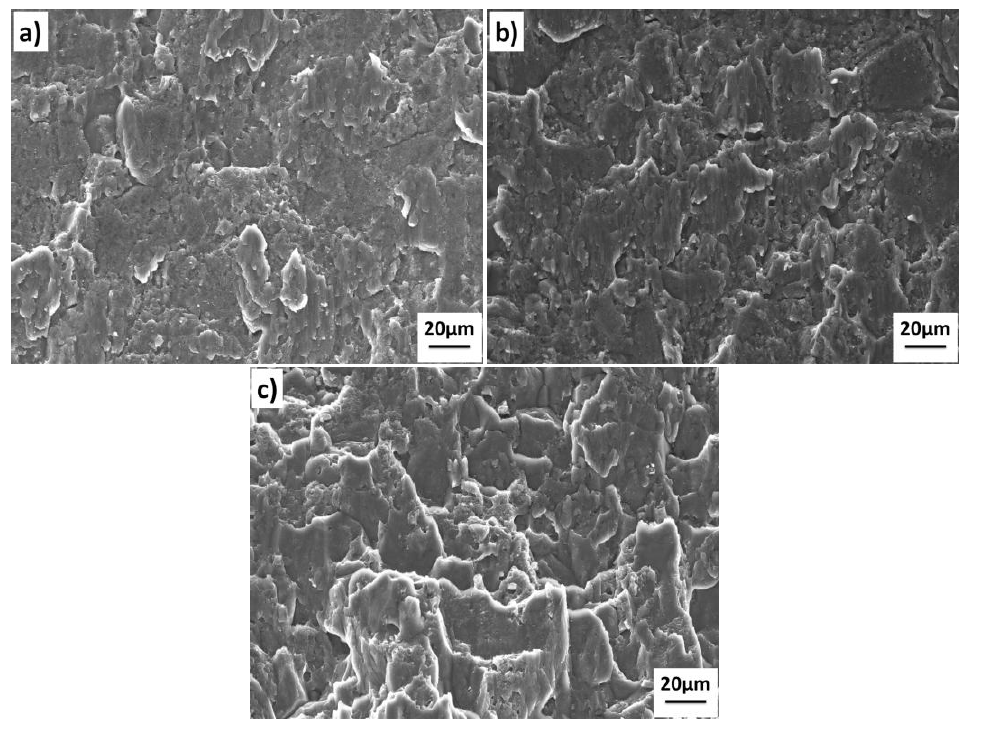
Figure 8. Shear test fractographs of the 1420-1420 joints after bonded at different temperatures: ( a ) 460 °C; ( b ) 490 °C; ( c ) 520 °C.